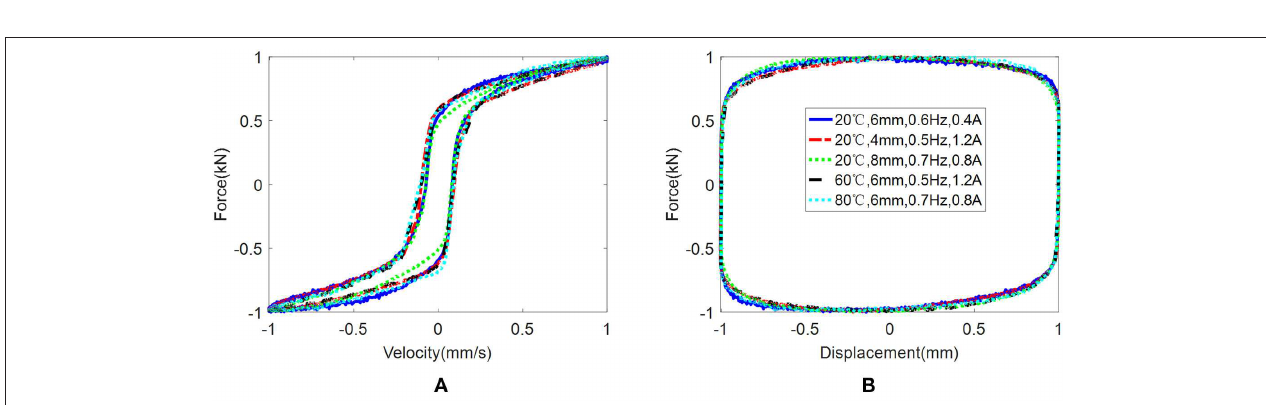
FIGURE 5 | Differences of experimental results and ideal symmetric loops under different temperatures: (A) force vs. velocity and (B) force vs. displacement.